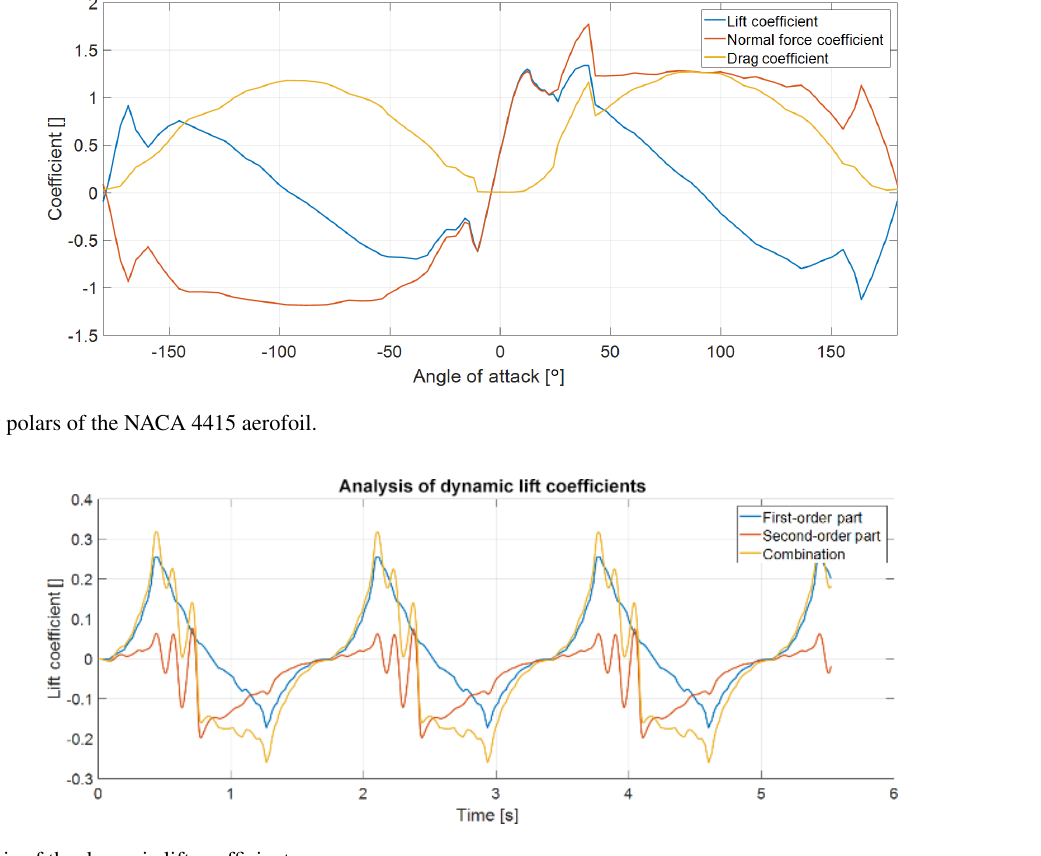
Figure 5. Analysis of the dynamic lift